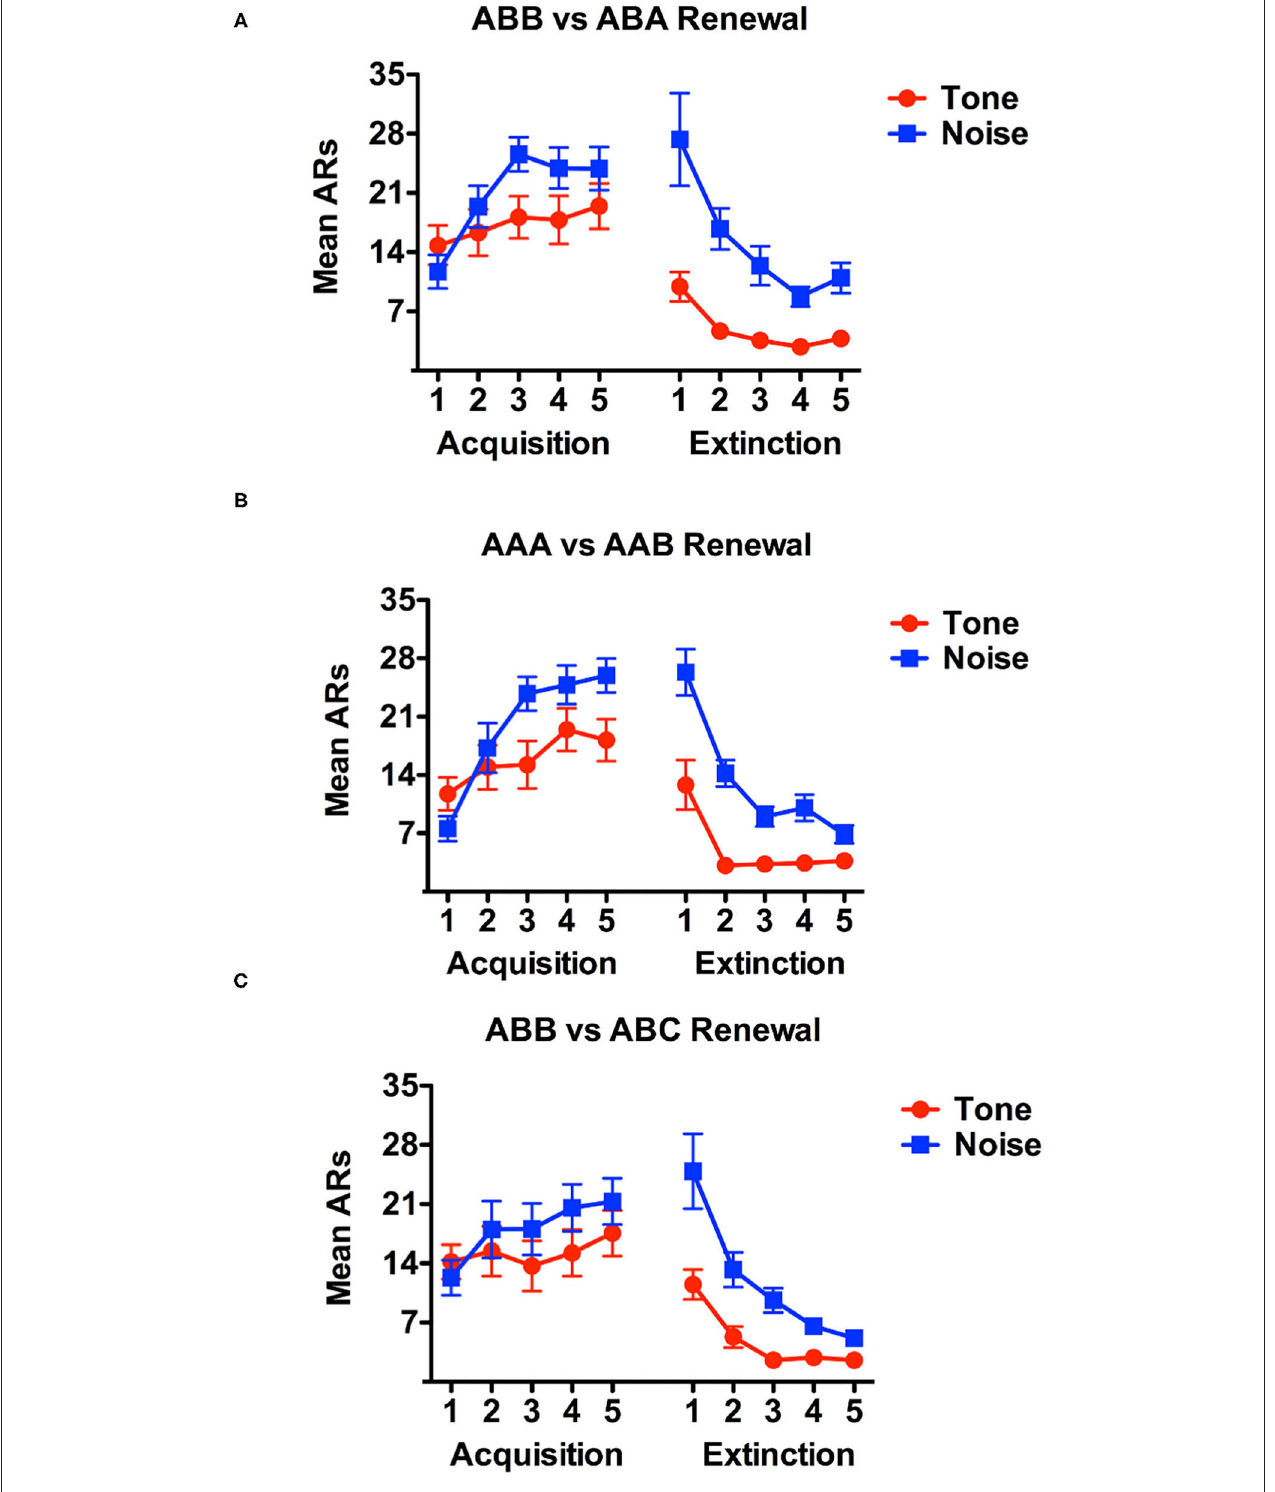
FIGURE 2 | Acquisition and extinction data during the first two phases of the study are presented for each renewal condition in this figure. ABA subject data are presented in (A) , while AAB data in (B) and ABC in (C) . During acquisition, data reflect avoidance responses (ARs) only, meaning, shuttles that occurred during the ITI or during the shock on failed trials do not count toward this graph. During extinction, all shuttles during the cue are counted as they reflect attempted ARs.